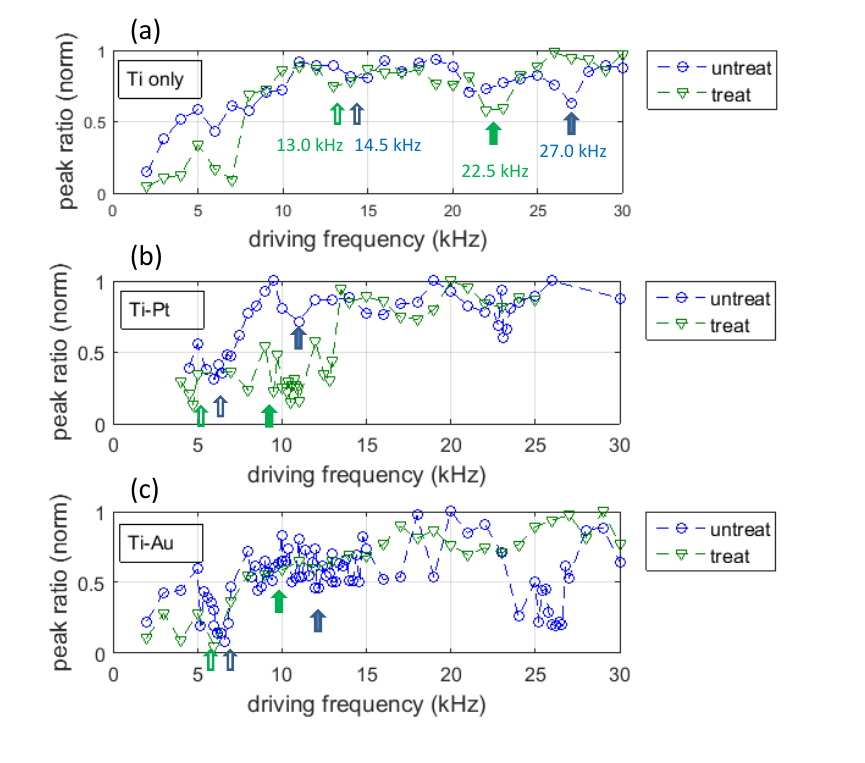
Figure 7. Peak ratio as a function of driving frequency. The valley frequencies indicated in ( a ) the Ti-only specimen are measured values. The valley frequencies pointed to by arrows in ( b ) Ti-Pt and ( c ) Ti-Au indicate valley frequencies estimated from those in ( a ) and the mass ratio defined in Table